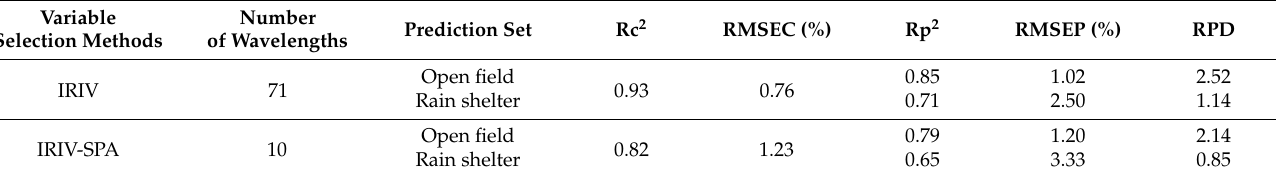
Table 4. Prediction results of SSC using IRIV and IRIV-SPA.